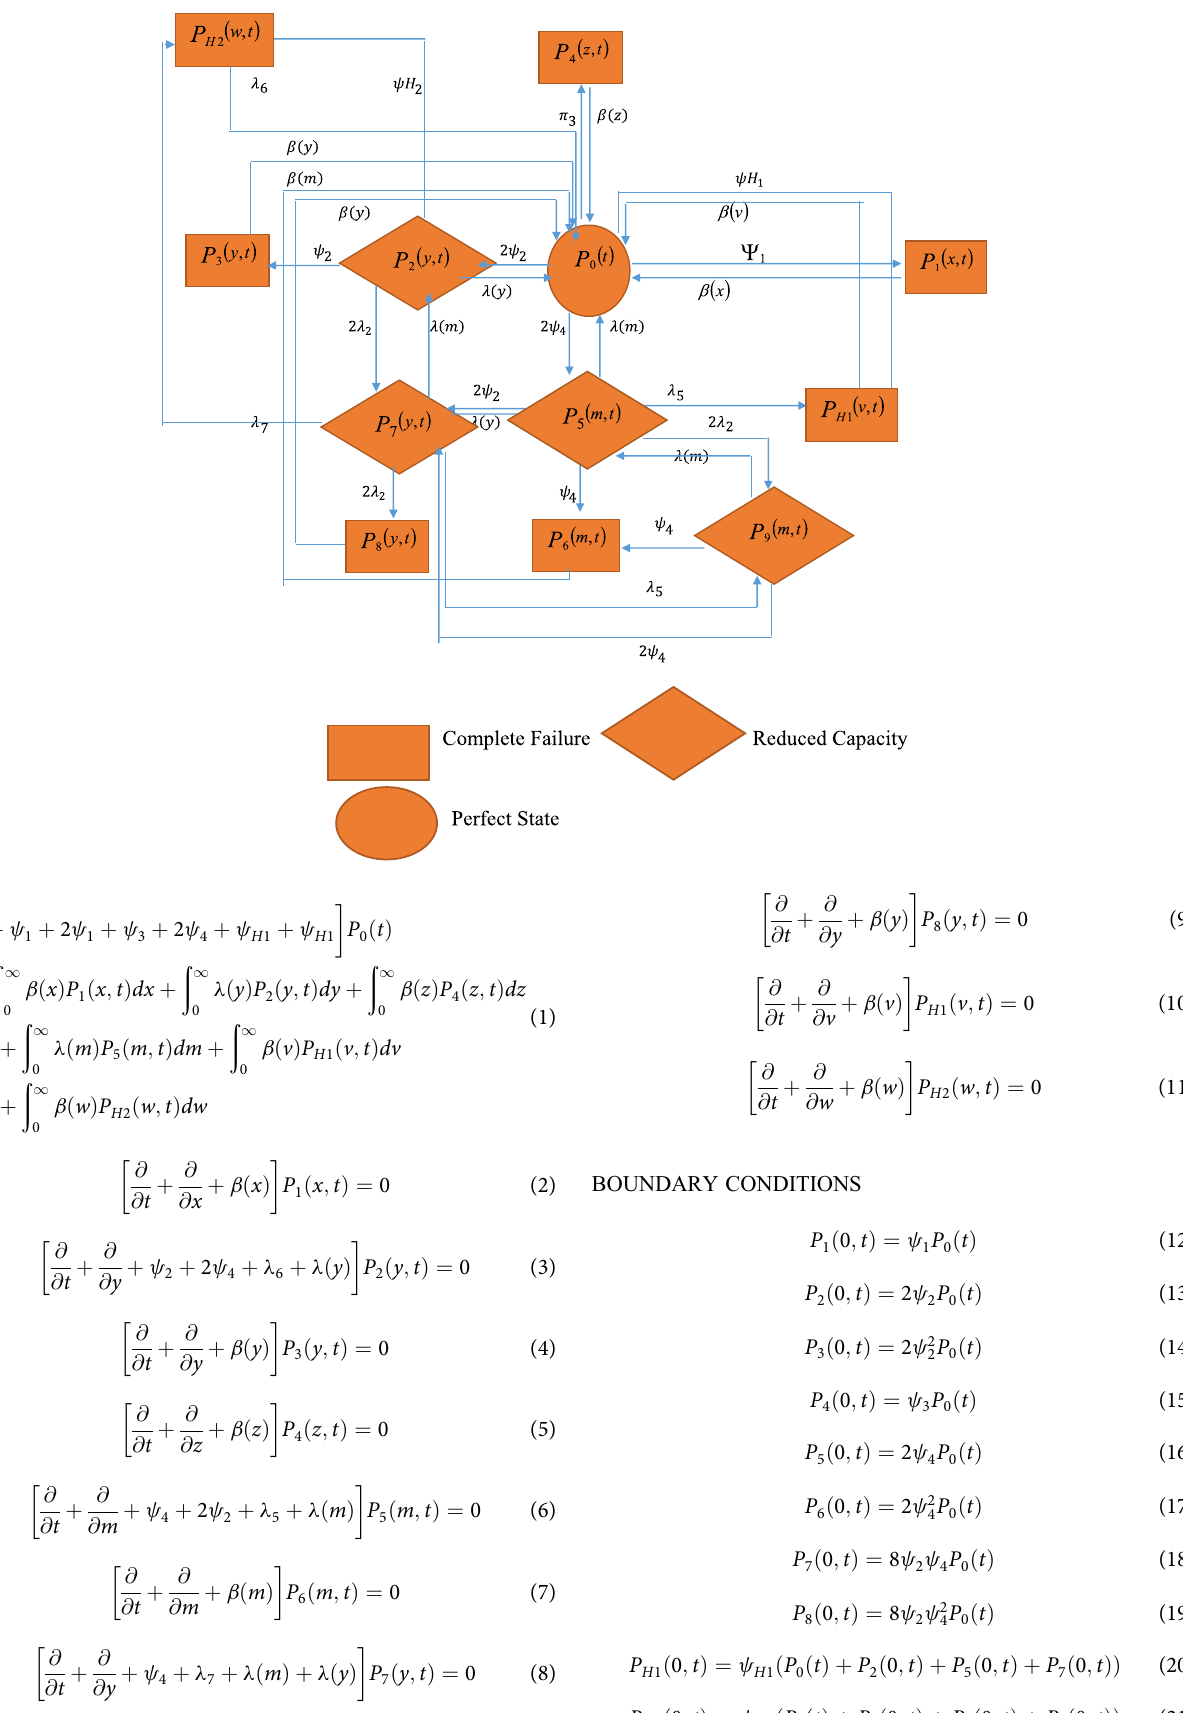
Figure 2 Model state transition